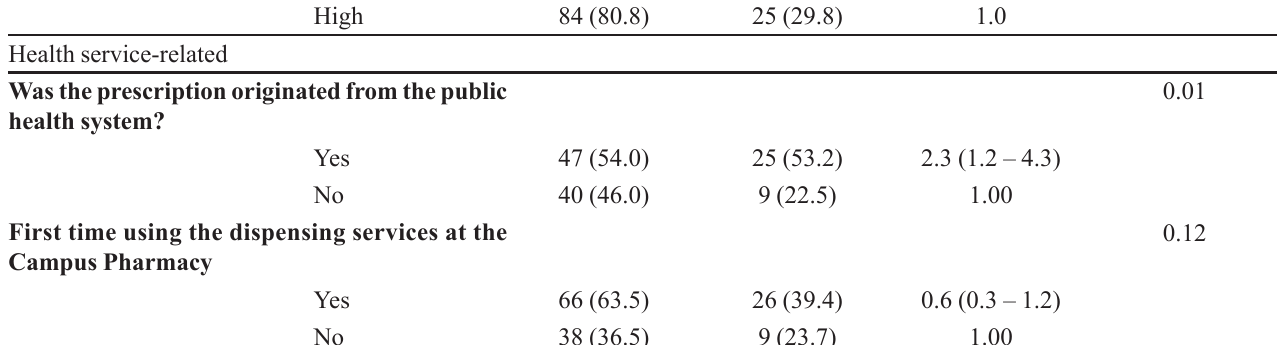
Characteristics of